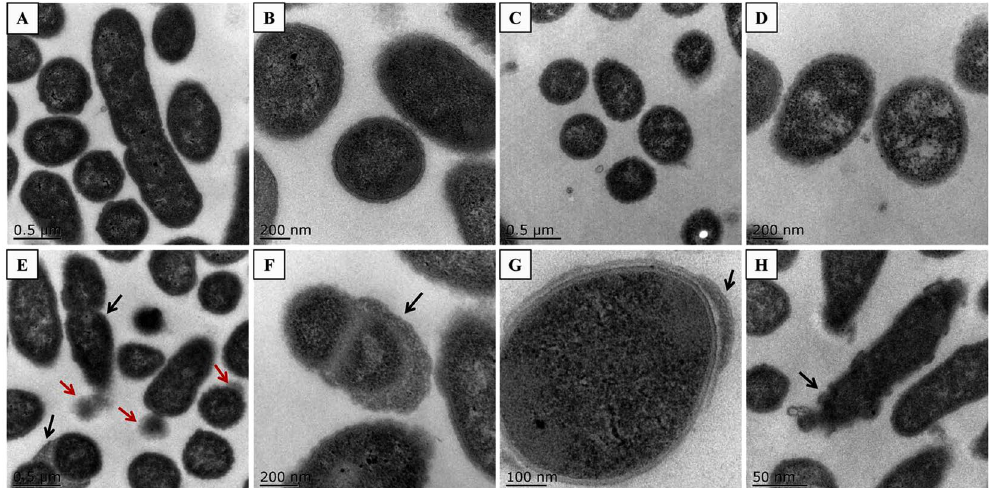
Figure 6. Cellular ultrastructure observation. ( A , B ) Phenotypes of wild-type strain Yb2. ( A ) Integral and regularly shaped cells, a few cells were in division; ( B ) regularly shaped cells at higher magnification. ( C , D ) Phenotypes of complemented strain cYb2 Δ bioF. ( C ) Integral and regularly shaped cells; ( D ) regularly shaped cells at higher magnification. ( E – H ) Phenotypes of mutant strain Yb2 Δ bioF. ( E ) Dropped vegetations (red arrows) and most cells were in division (black arrows); ( F ) relatively thickened cell walls (black arrow); ( G ) partially thickened cell walls (black arrow); ( H ) irregular shapes (black arrow).